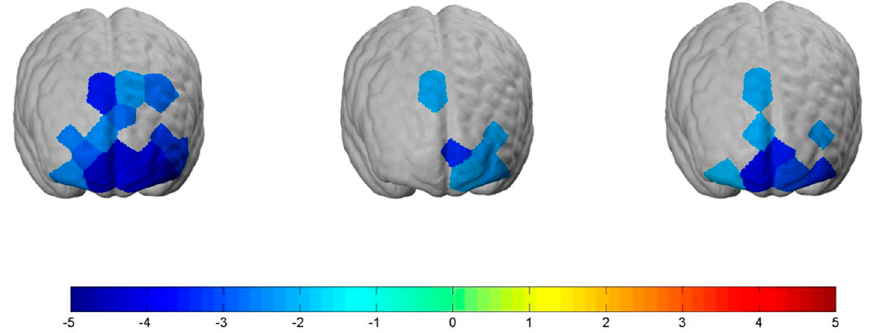
Figure 4. Significantly decreased neural prefrontal cortex activation for the main effects of the “Neutral” ( left brain), “Stop” ( middle brain), and “Shock” condition ( right brain). Activation threshold set to p < 0.05 .